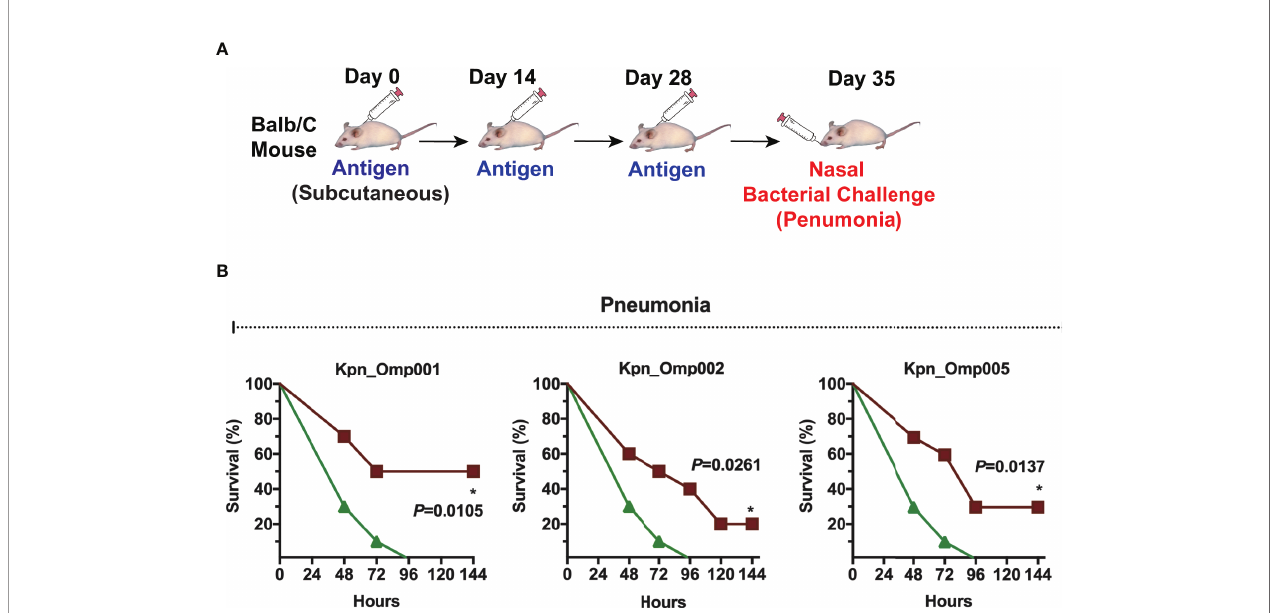
FIGURE 4 | Murinepneumoniamodel. (A) Balb/cmice were immunized with the KOMPs individually or PBS. Seven days after the secondbooster vaccination,different doses of K pneumoniae 260 in 50 m l ofPBS were injected intranasally into mice. (B) The survivalrate of murine pneumonia model was observed for 144 h. *p < 0.05.